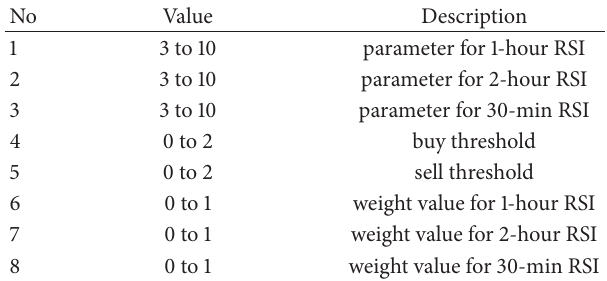
Table 6: DE parameter vector